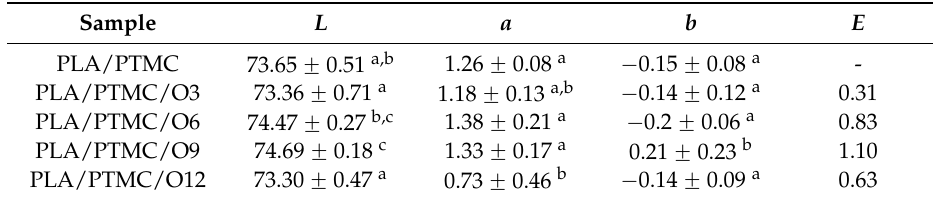
Figure 4. Color of ( a ) PLA/PTMC; ( b ) PLA/PTMC/O3; ( c ) PLA/PTMC/O6; ( d ) PLA/PTMC/O9 and ( e ) PLA/PTMC/O12. Table 2. The visual properties of PLA/PTMC/OEO composite